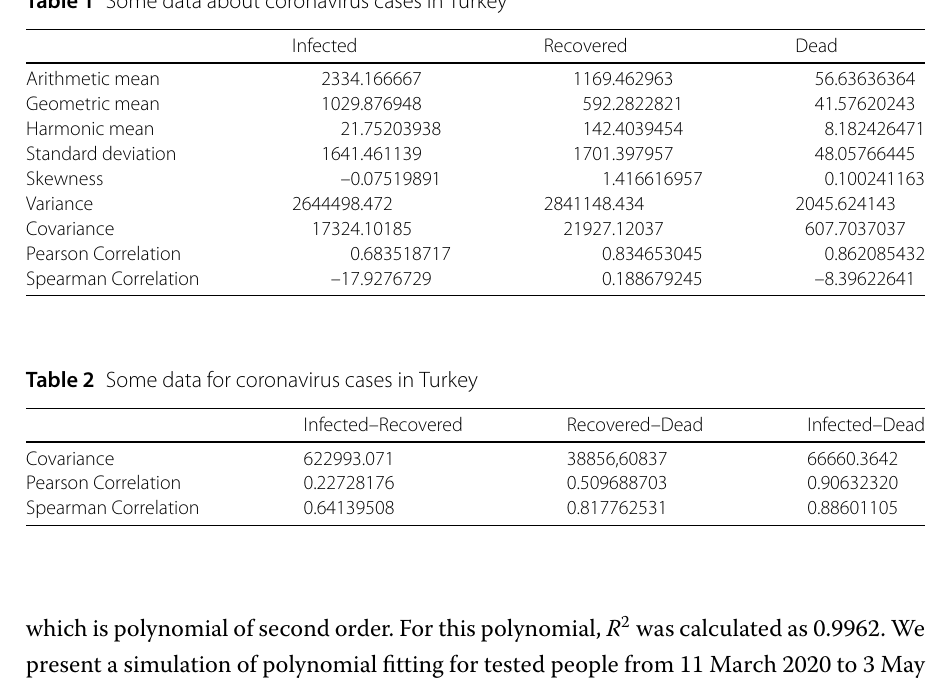
Table 1 Some data about coronavirus cases in Turkey Infected Recovered Dead Arithmetic mean